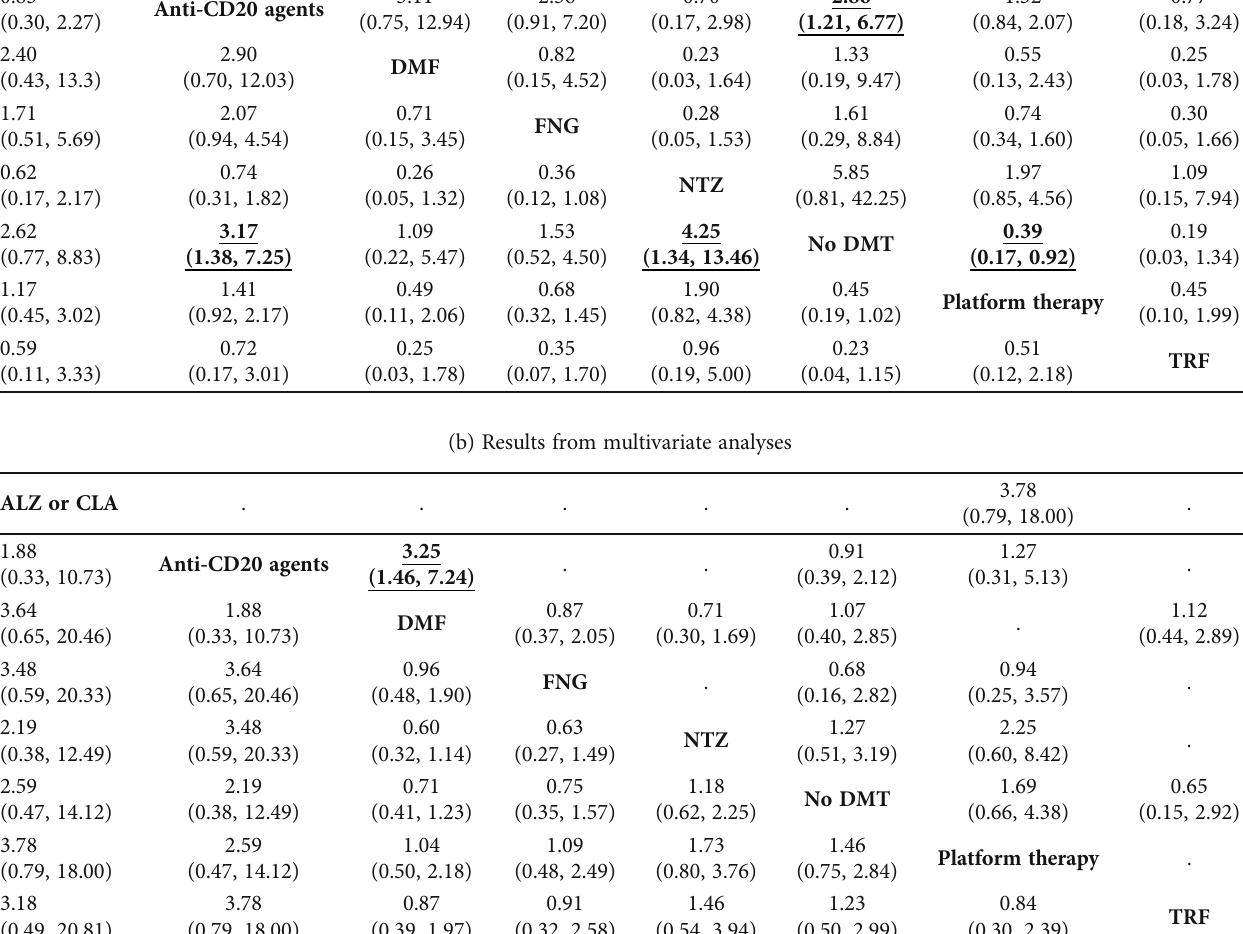
Table 2: League table showing the results of network meta-analysis comparing the e ff ect of DMTs on the risk of getting COVID-19. (a) Results from univariate analyses ALZ or